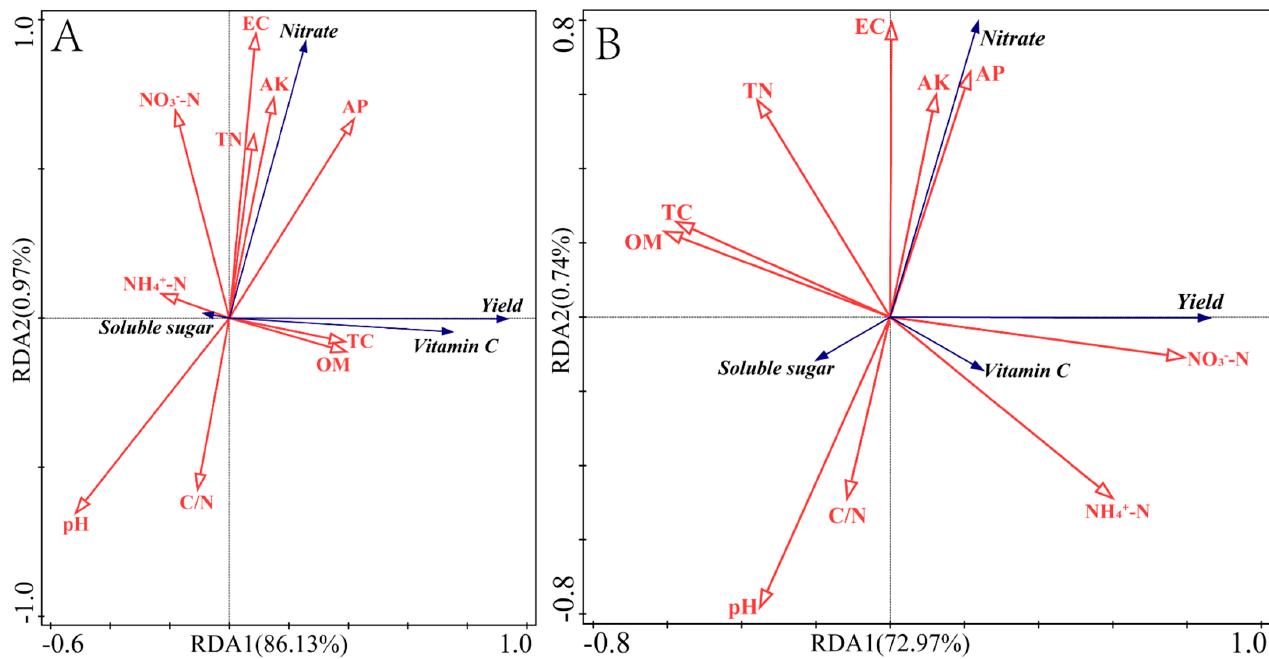
Figure 4. ( A ) is biplot of the first two axes of the RDA for Cambisols’ chemical properties and vegetable’s yield and quality; ( B ) is biplot of the first two axes of the RDA for Alisols’ chemical properties and vegetable’s yield and quality.